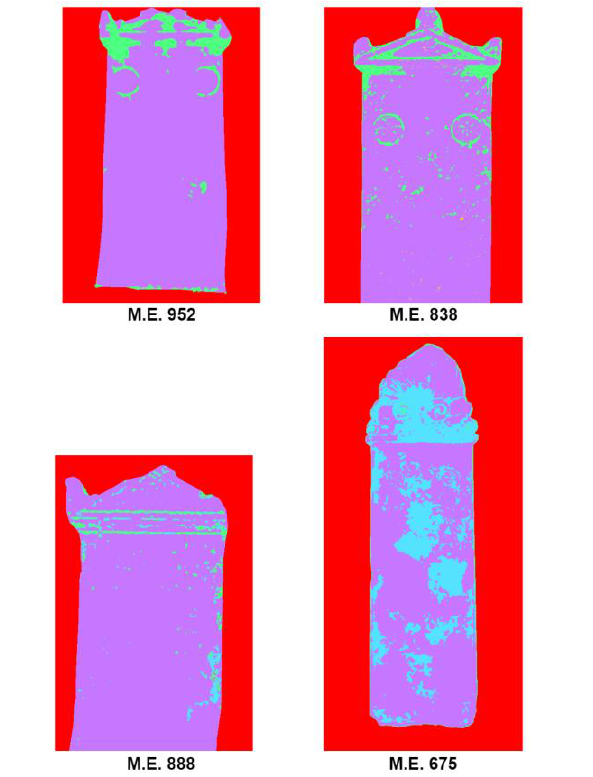
Figure 5. Degradation mapping of stelae using the trained classifiers and the NIRRG